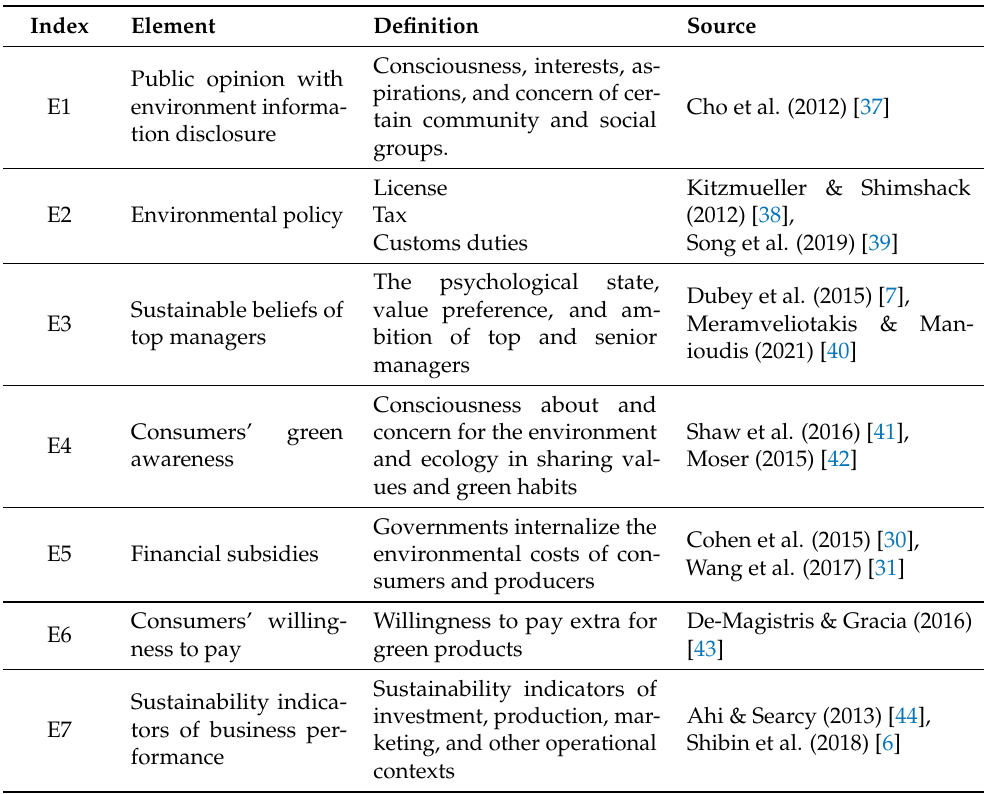
Table 1. The driving elements in GTA.